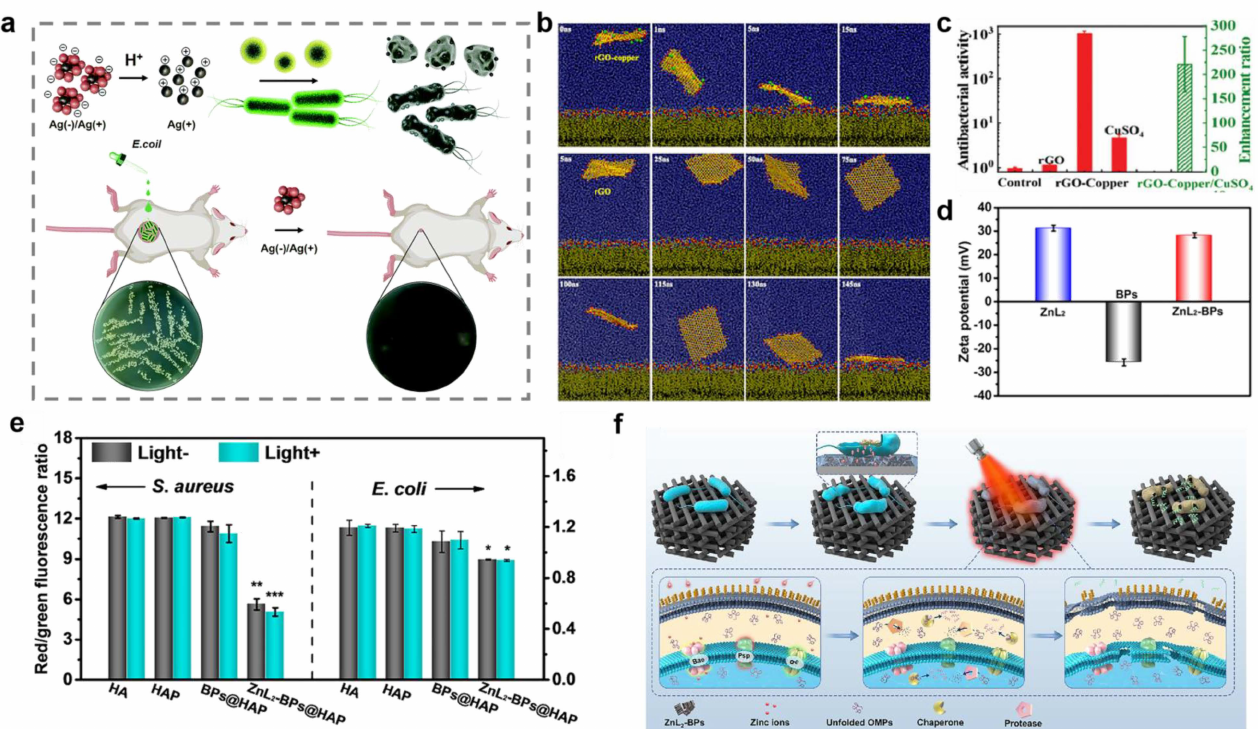
Figure 2. Disruption of bacterial cell membranes through electrostatic interactions. ( a ) Schematic illustration for bacterial killing by acid-responsive Ag ( − )/Ag (+) clusters. ( b ) Trajectory of binding between cell membrane and reduced graphene oxide (rGO)-copper composite and rGO. ( c ) An- tibacterial activity ( left axis) of rGO-copper composite and enhancement ratio ( right axis) compared to copper ions. ( d ) Zeta potentials of zinc sulfonate ligand (ZnL 2 ), black phosphorus nanosheets (BPs), and ZnL 2 -BPs. ( e ) Bacterial membrane potentials. * denotes p < 0.05, ** denotes p < 0.01, and *** denotes p < 0.001 compared with the hydroxylapatite (HA) group without near infrared (NIR)- irradiation. ( f ) The antibacterial mechanism of ZnL 2 -BPs@HAP. ( d – f ) Reprinted with permission from Ref [71]. Copyright 2021 American Chemical